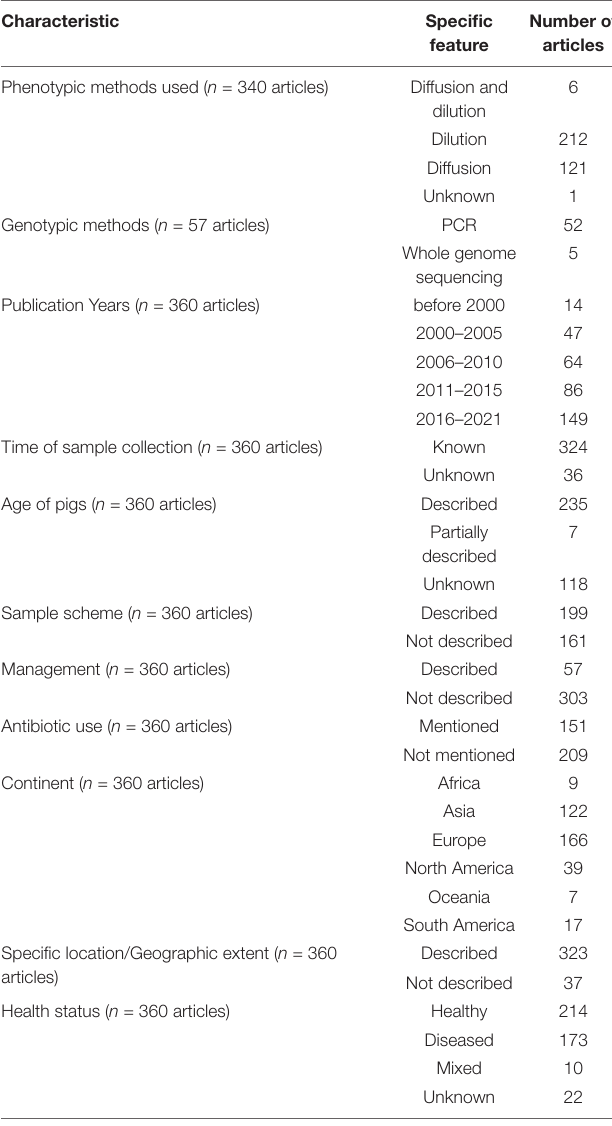
TABLE 1 | General characteristics of the data reported in the articles